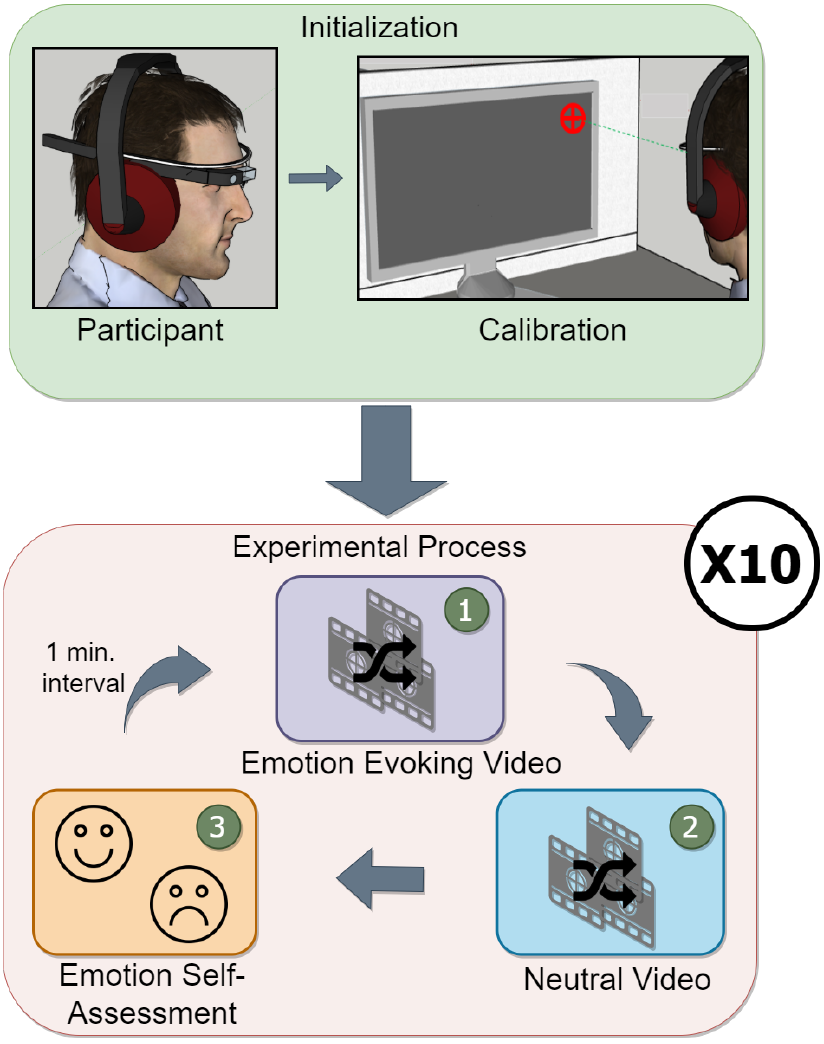
Figure 3. Design of the experimental